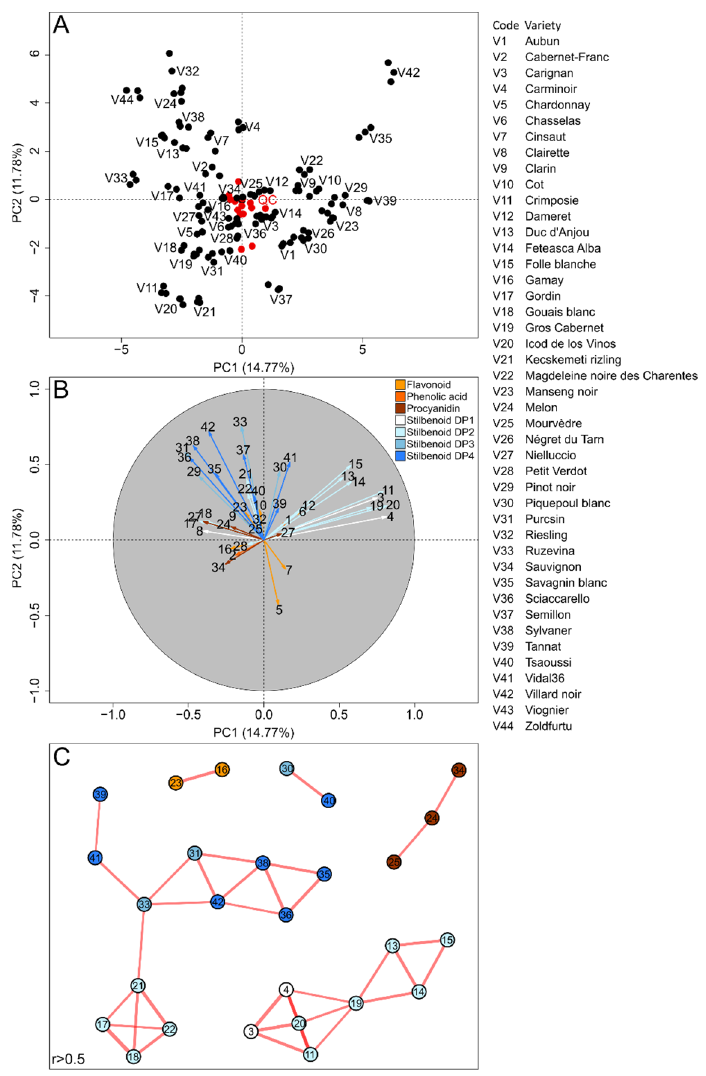
Figure 1. Unsupervised classification using PCA performed on the metabolomics profiles of 44 European grape varieties. Score plot ( A ) on samples (dark) and QC (red). Loading plot ( B ) with variables colored according to the polyphenol class and numbered according to metabolite names given in the Materials and Methods section. Spearman correlation-based networks of polyphenol metabolism ( C ), node numbers represent the metabolites and the color refers to the polyphenol class. Short edge distances indicate the Spearman coefficient importance and the correlation significance.